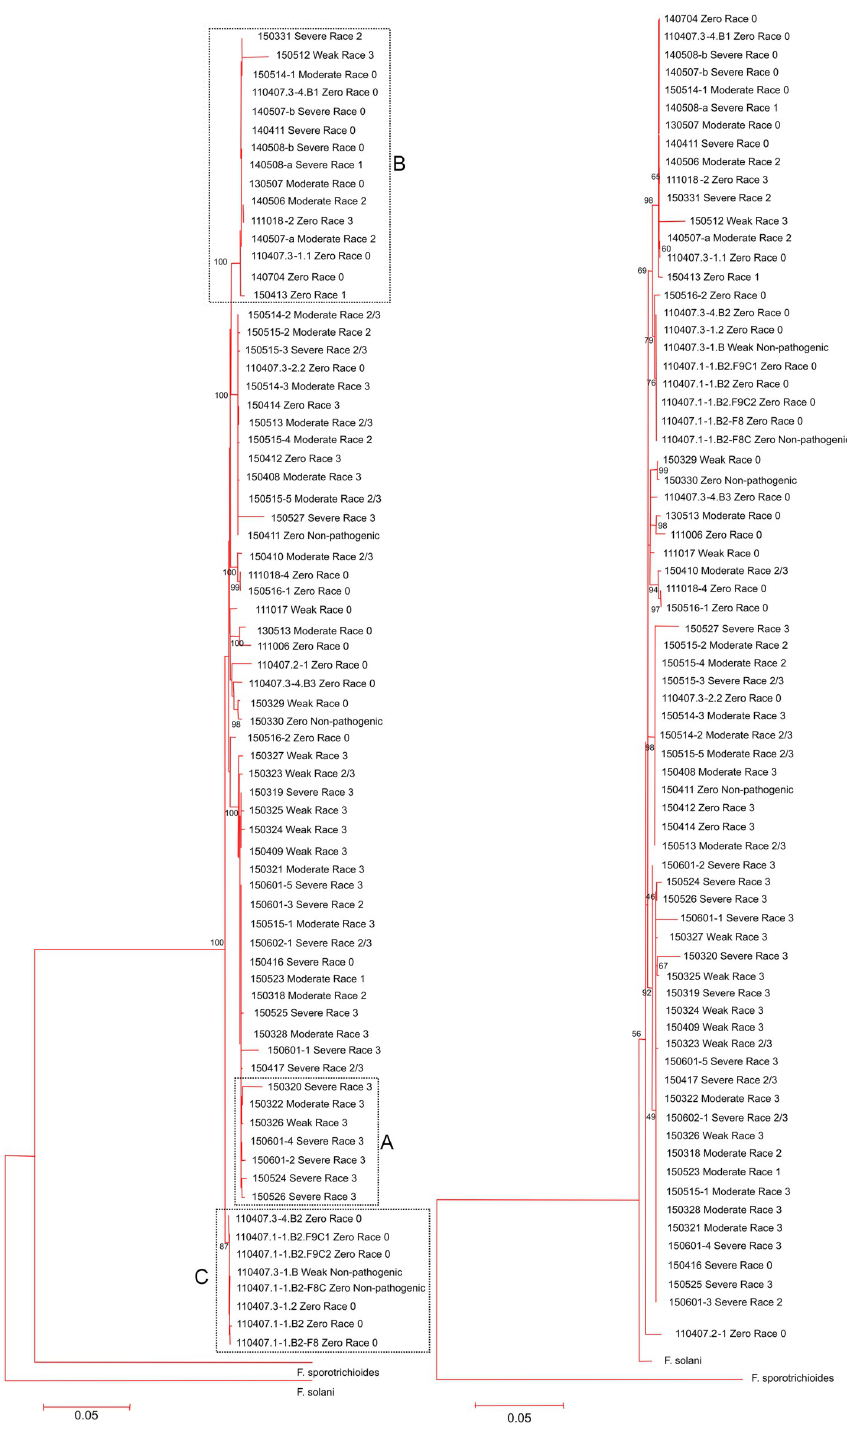
Fig 1. Molecular phylogenetic analysis from concatenated gene sequences. The evolutionary history was inferred by using a (A) Neighbor-joining (NJ) tree with Kimura-2-parameter and a (B) Maximum Likelihood method based on the nearest-neighbor interchange algorithm and general time-reversible (GTR) substitution model. The bootstrap values > 65% from 500 replications are shown above the branches. Trees are drawn to scale, with branch lengths measured in the number of substitutions per site. 74 nucleotide sequences were included in the analysis. All positions containing gaps and missing data were eliminated.